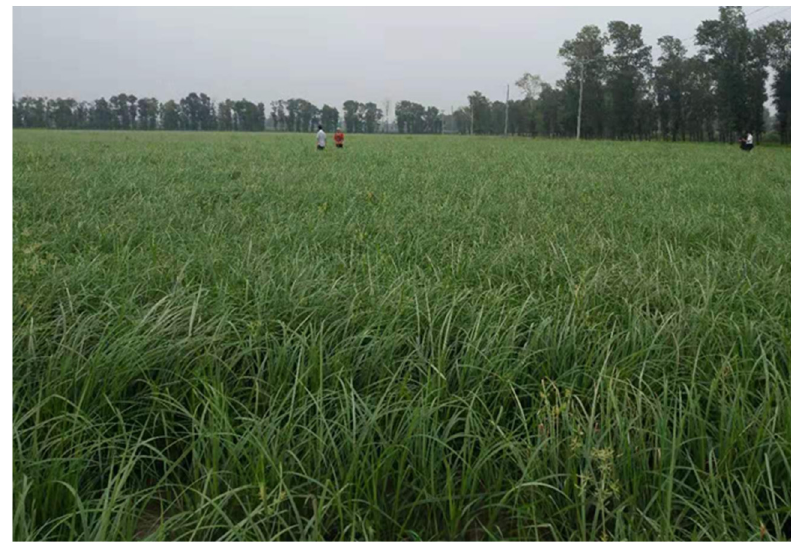
Figure 1. Cyperus ( Cyperus esculentus L.) in growth stage.